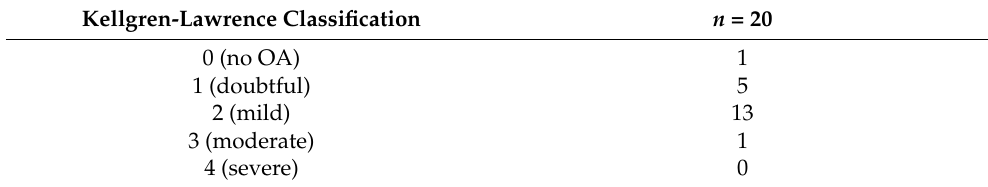
Table 3. Kellgren-Lawrence Classification of 20 patients with confirmed osteoarthritis on pre- operative